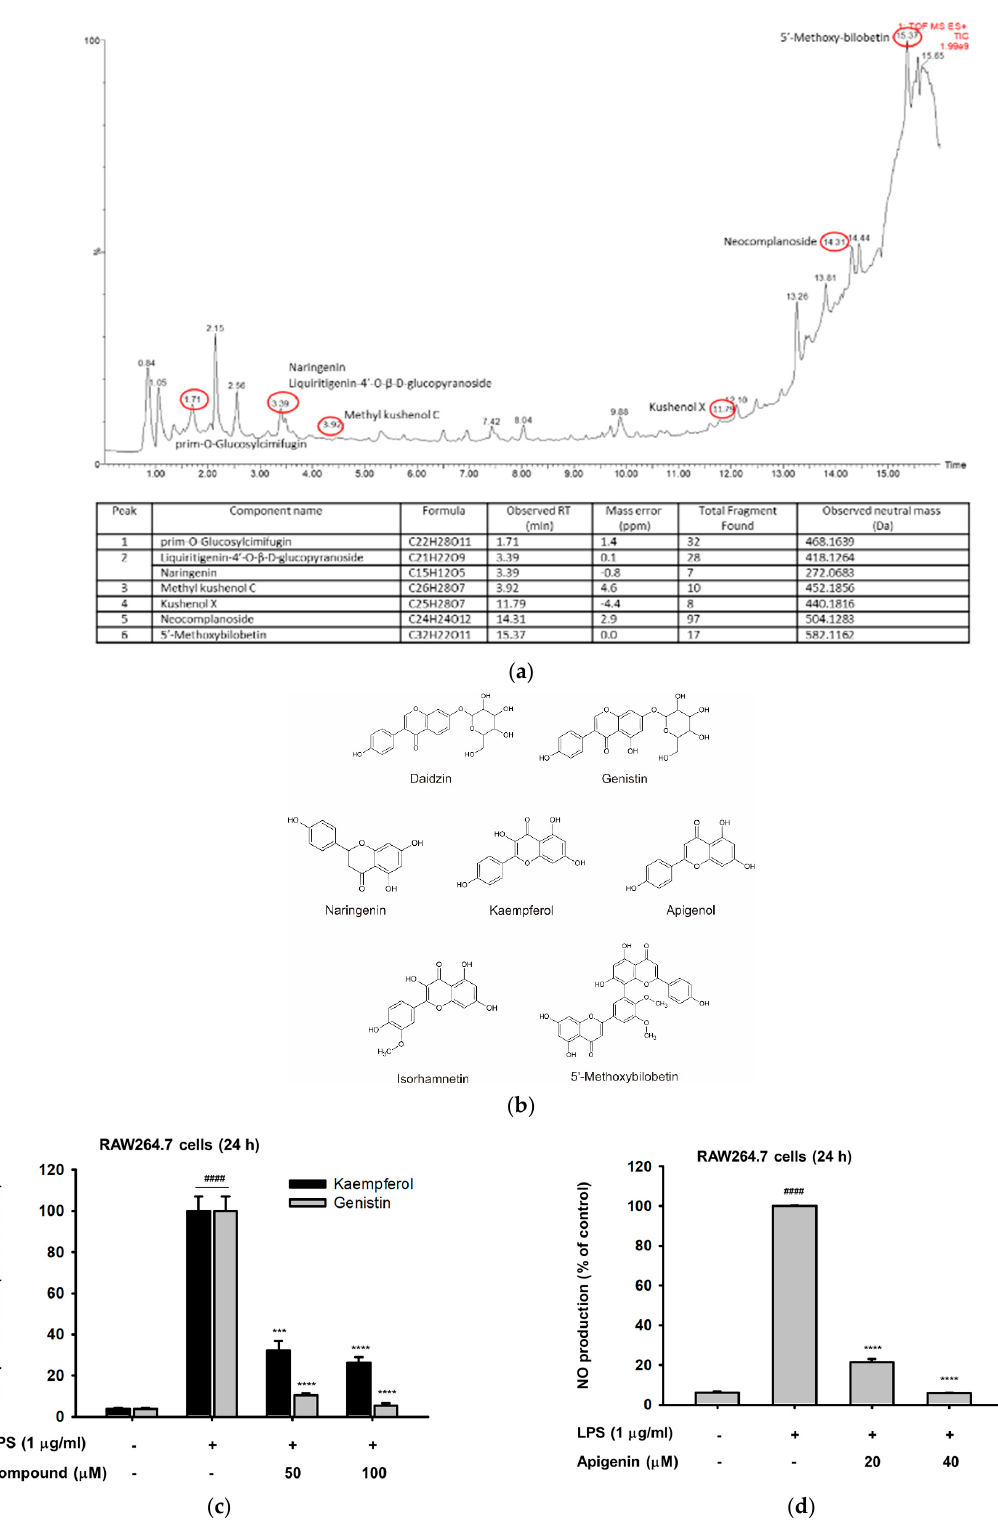
Figure 2. The phytochemical constituents of Cs-EE. ( a ) LC/MS-MS chromatogram of Cs-EE. ( b ) Chemical structure of the well-known flavonoids that was identified in Cs-EE. ( c , d ) Supernatant NO levels in RAW264.7 cell cultures pre-treated with indicated concentrations of ingredient compounds (kaempferol, genistin, and apigenin) in the presence or absence of LPS (1 µ g/mL), were determined using the Griess assay. Results ( b , c ) are expressed as mean ± SD. #### p < 0.0001 compared to normal group (no treatment), *** p < 0.001 and **** p < 0.0001 compared to control group (LPS alone). A p -value was analyzed using the student’s t